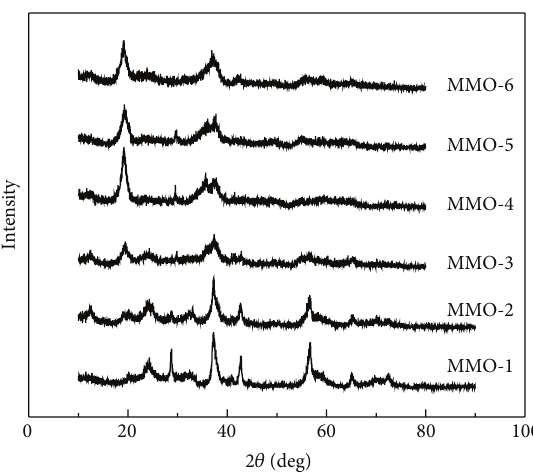
Figure 2: XRD patterns of the samples of MMO- 𝑥 ( 𝑥 = 1–6).